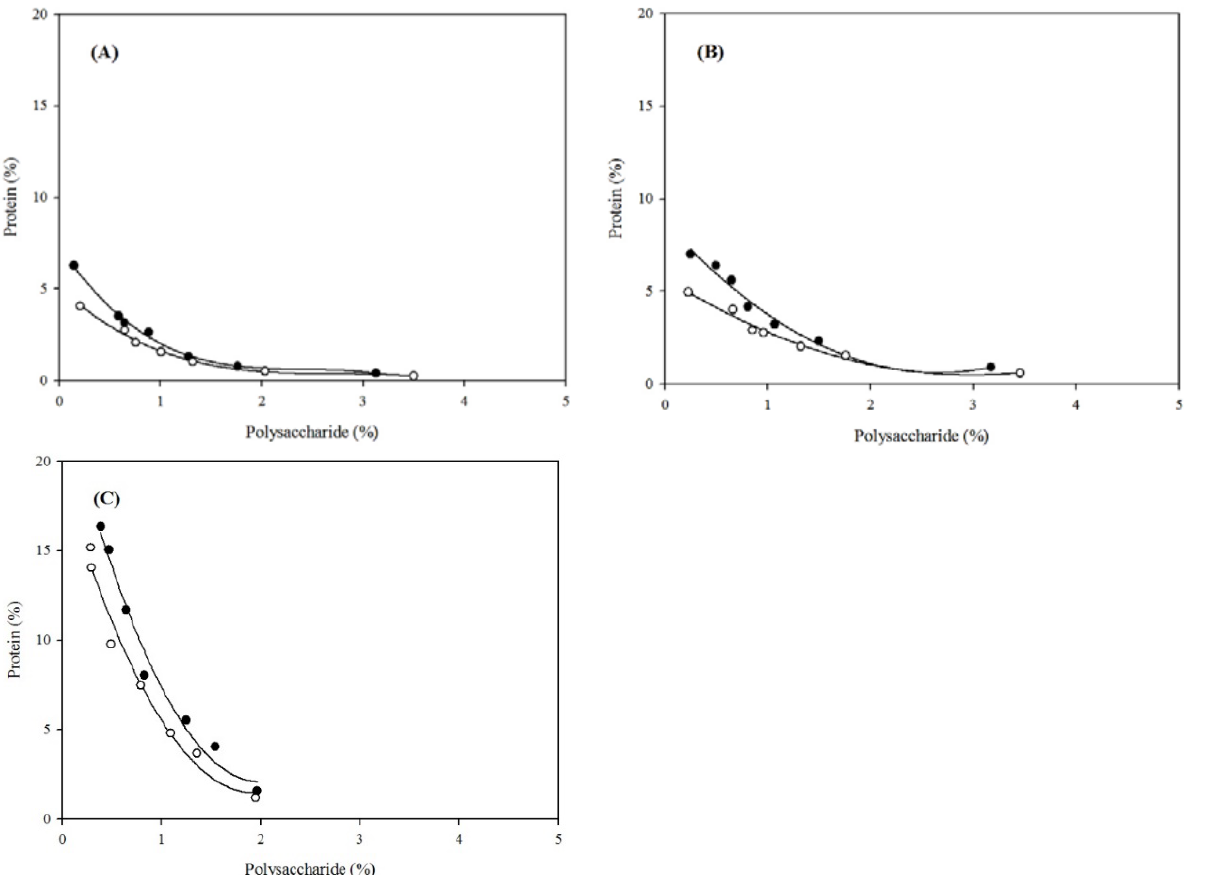
Figure 9. Phase diagram of binary mixtures of chia seed mucilage (● unpurified, ○ purified) and different proteins: ( A ) soy protein isolate, ( B ) sodium caseinate, ( C ) whey protein isolate. The points in the figure are experimental values. The line is the predicted value of Y in the equation of Y = Y 0 + A × exp ( − R0 × X) . The values of Y 0 , A, R 0 , and determination coefficient are shown in